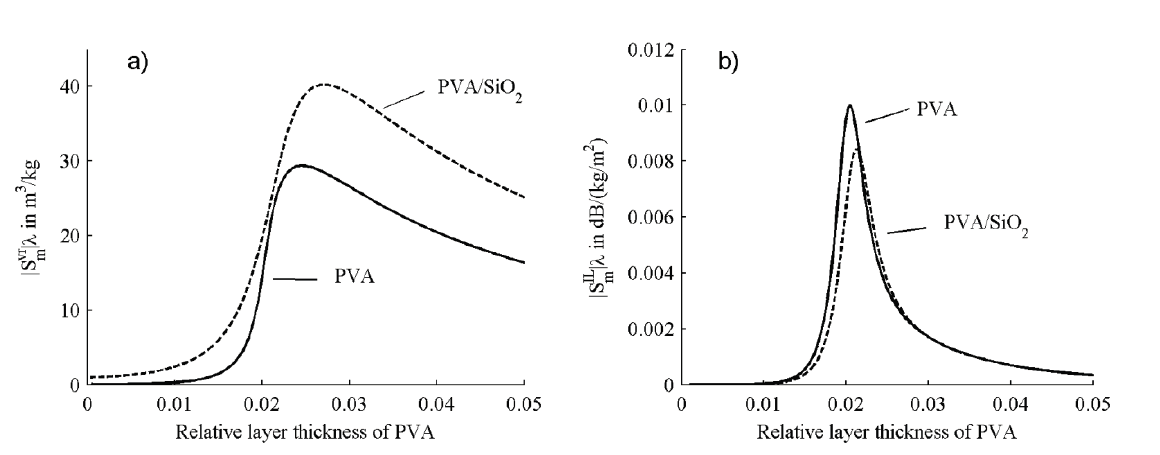
Figure 2. Mass velocity sensitivities ( a ) and mass loss sensitivities ( b ) of Love